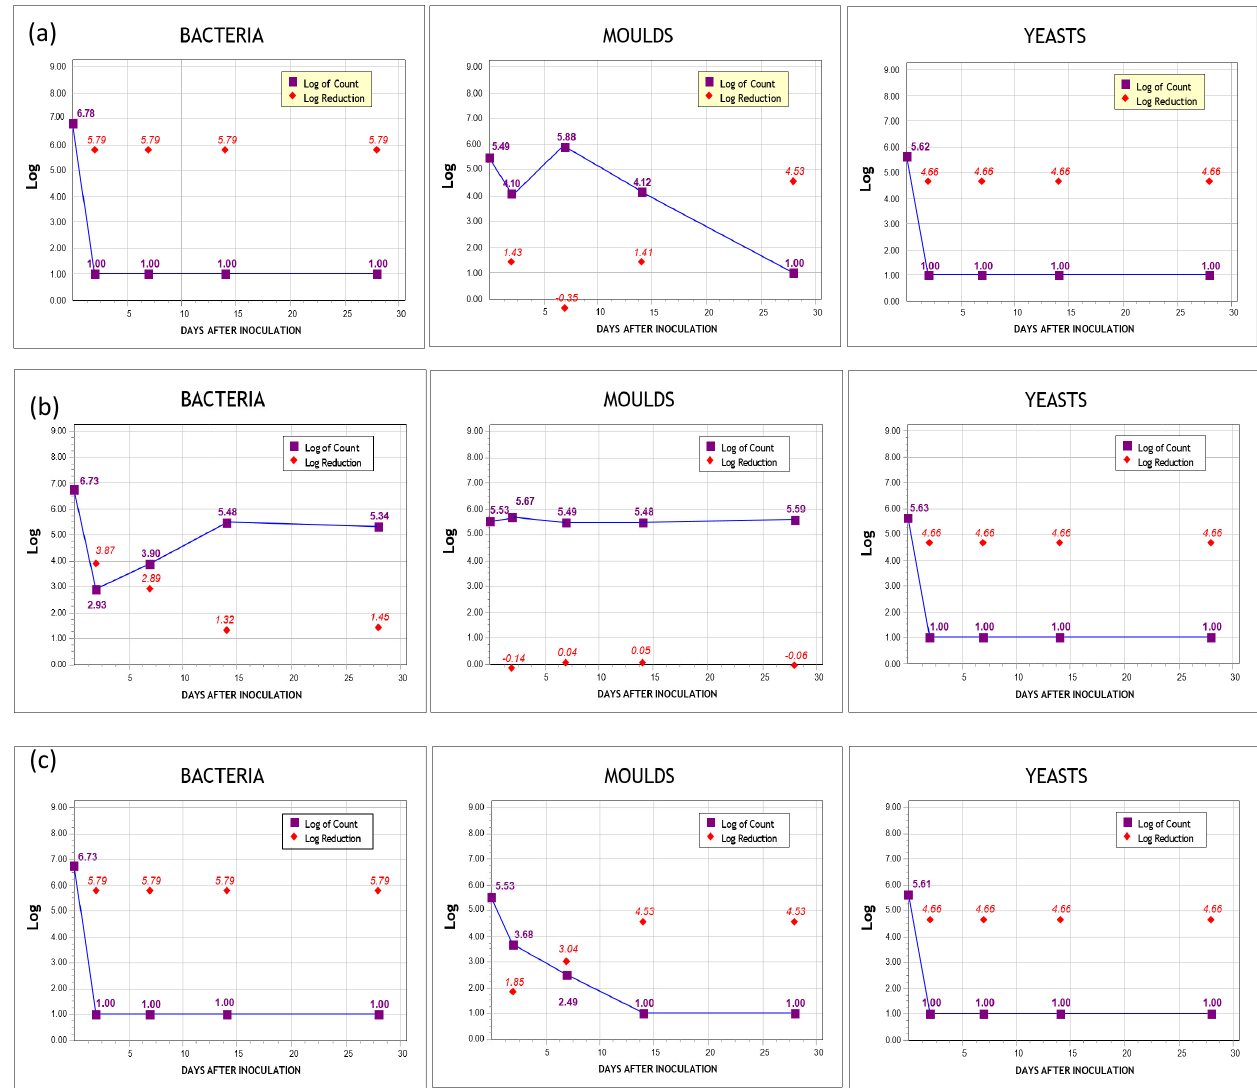
Figure 5. Logarithmic reduction charts of each sample against bacteria, molds, and yeasts ( a ) CuBentp, ( b ) ZnBentp, and ( c ) PHBentp.